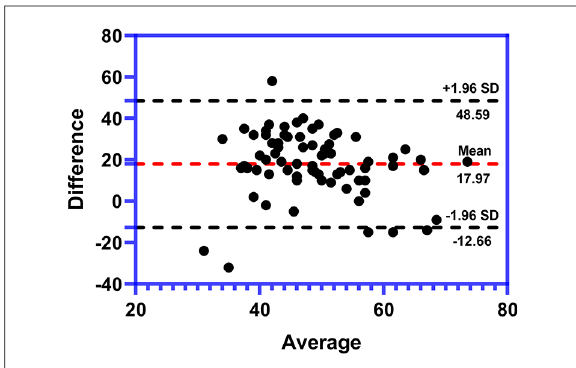
FIGURE 3 Bland – Altman plot of the consistence between PTI and SPI at the end of surgery ( n =72). The average difference (bias) between PTI and SPI is 17.97. The SD of the difference is 15.62. There is a 4.1% (3/72) of all plots outside the agreement lines suggesting a good consistency between PTI and SPI. SPI, surgical pleth index; PTI, pain threshold index; SD, standard